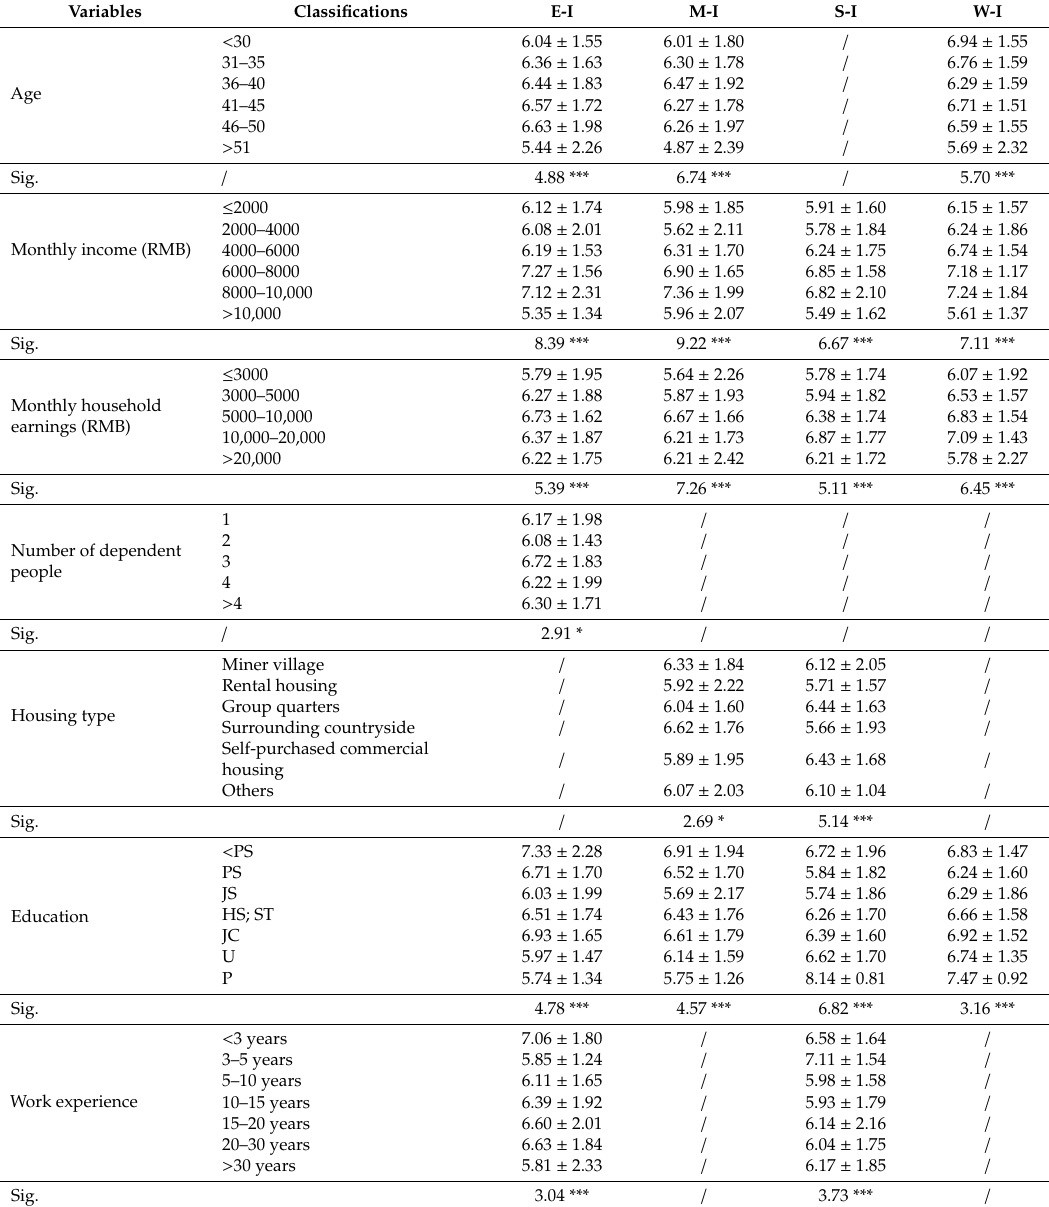
Table 3. Means (SDs) for socio-demographic variables for the realistic environment, managers, supervisors, and co-workers’